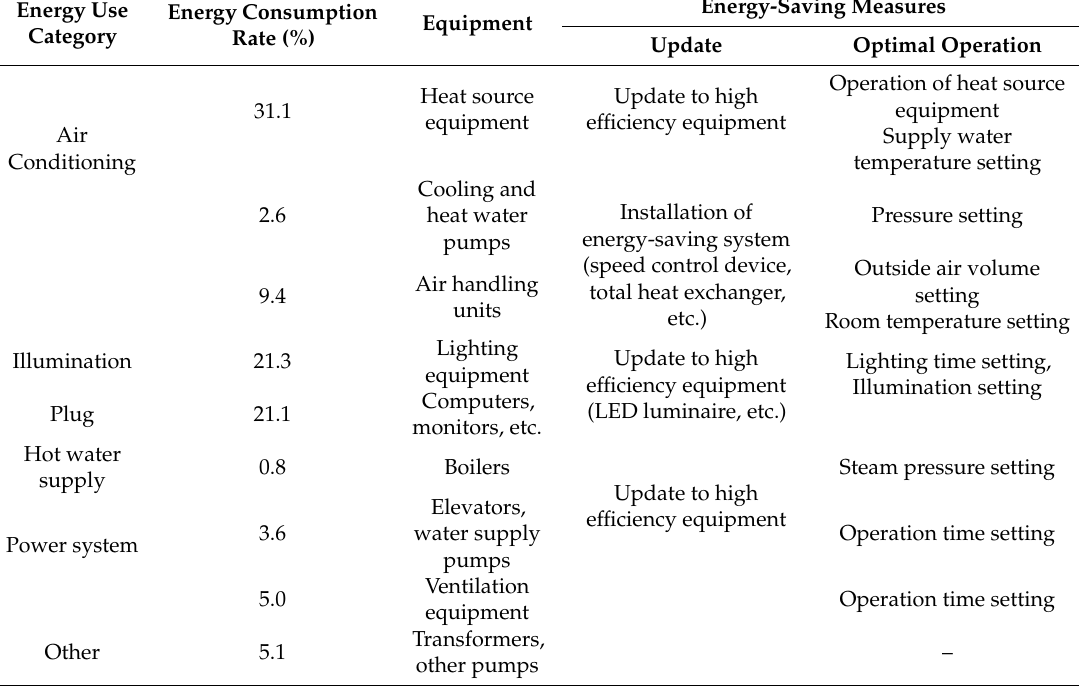
Table 2. Energy use categories, energy consumption rates, and energy-saving methods for any one